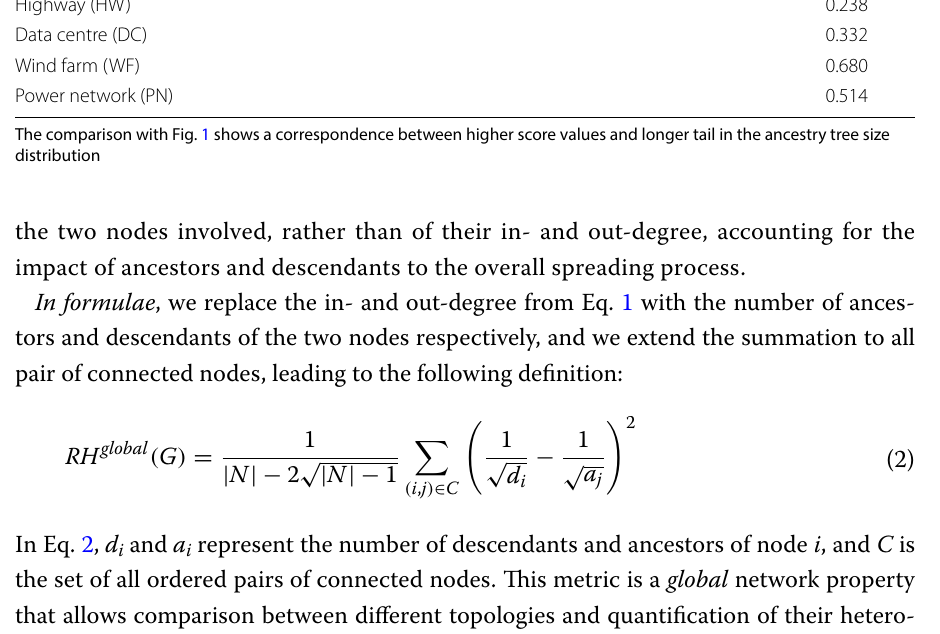
Table 2 Global RH scores for the four activity networks